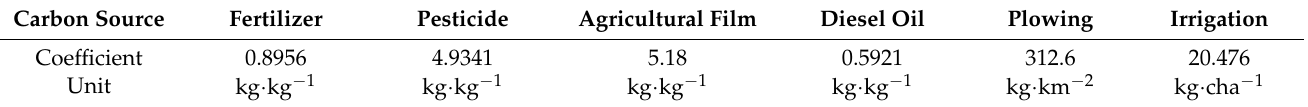
Table 4. Agricultural space carbon emission calculation